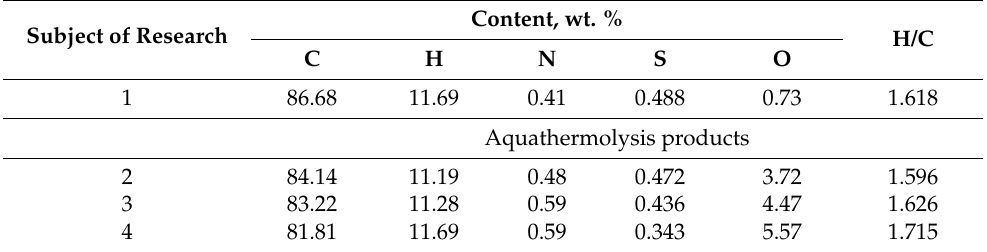
Table 3. Elemental analysis of the oil extract before and after experiments.